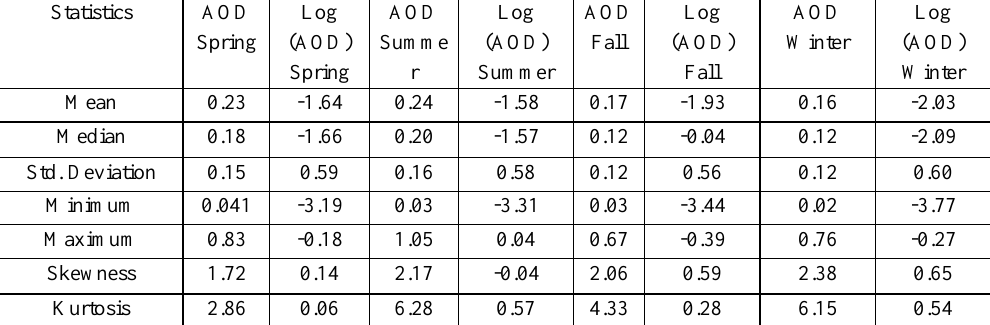
Table 1: Data characteristic of seasonal mean AOD data